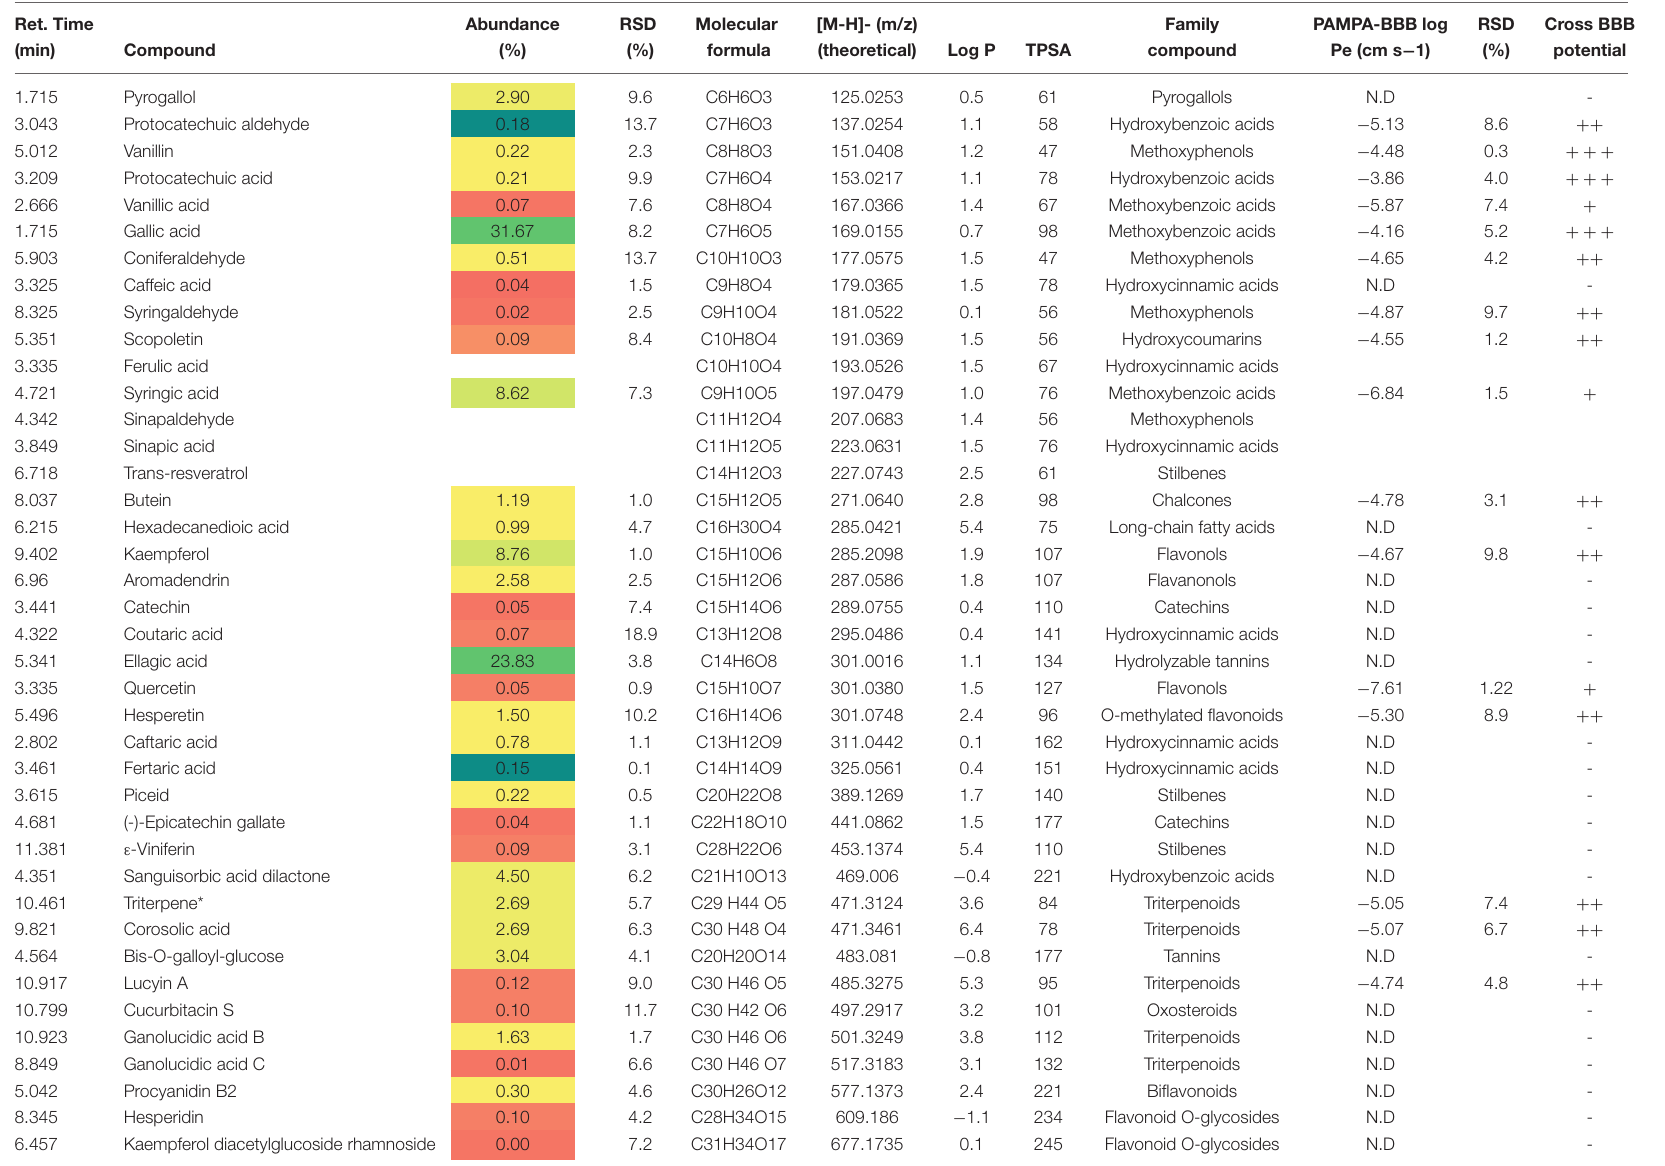
TABLE 4 | Phytochemical profile, abundance (%), and BBB permeability of LPLE (Nothofagus pumilio, lenga PLE extract). Ret.